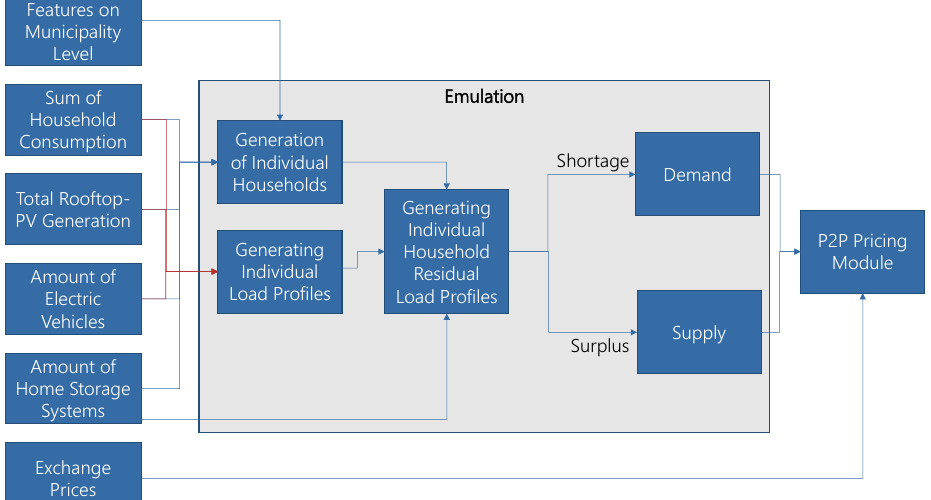
Figure 12. Detailed structure of the simulation model and the parts substituted by our emulation- model (gray).